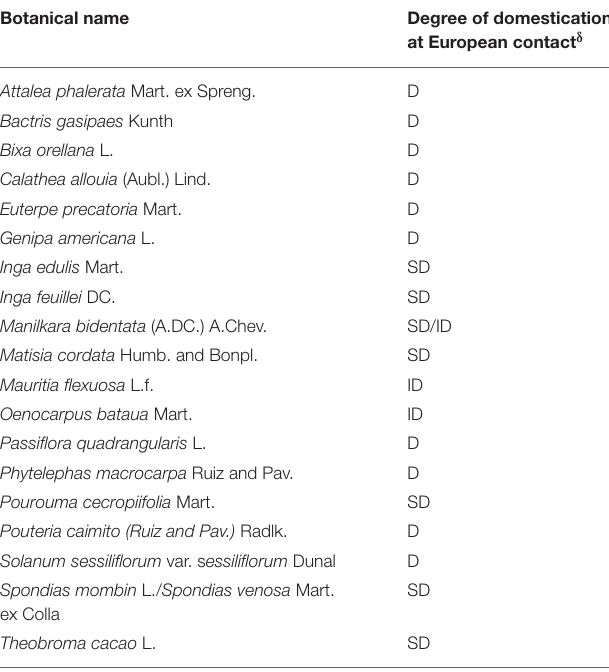
TABLE 6 | “Wild” food plant species that were reported as domesticated (D), semi-domesticated (SD), and with incipiently domesticated populations (ID) in Amazonia at European contact (Clement, 1999; Levis et al.,